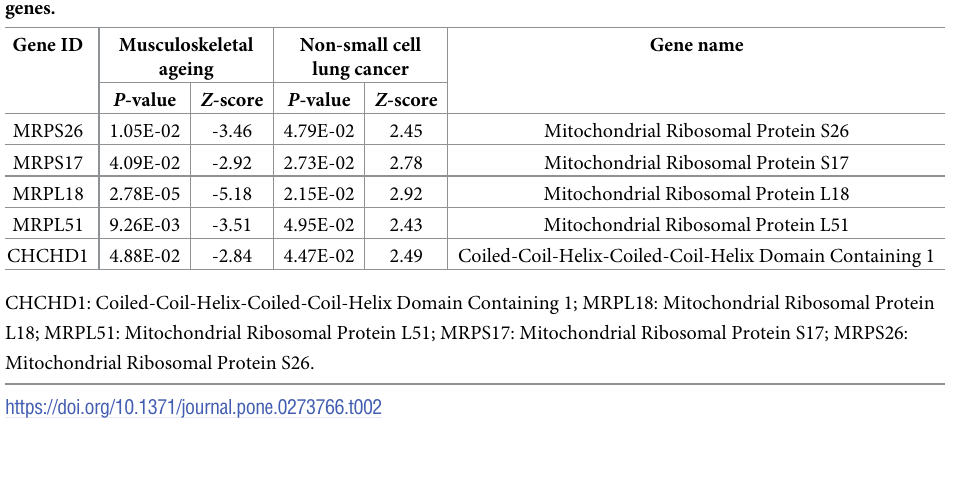
Table 1. Gene composition of the highest-ranked clustering modules in the protein-protein interaction network of differentially expressed genes of musculoskeletal ageing and non-small cell lung cancer. Cluster MCODE Gene Gene score density edges